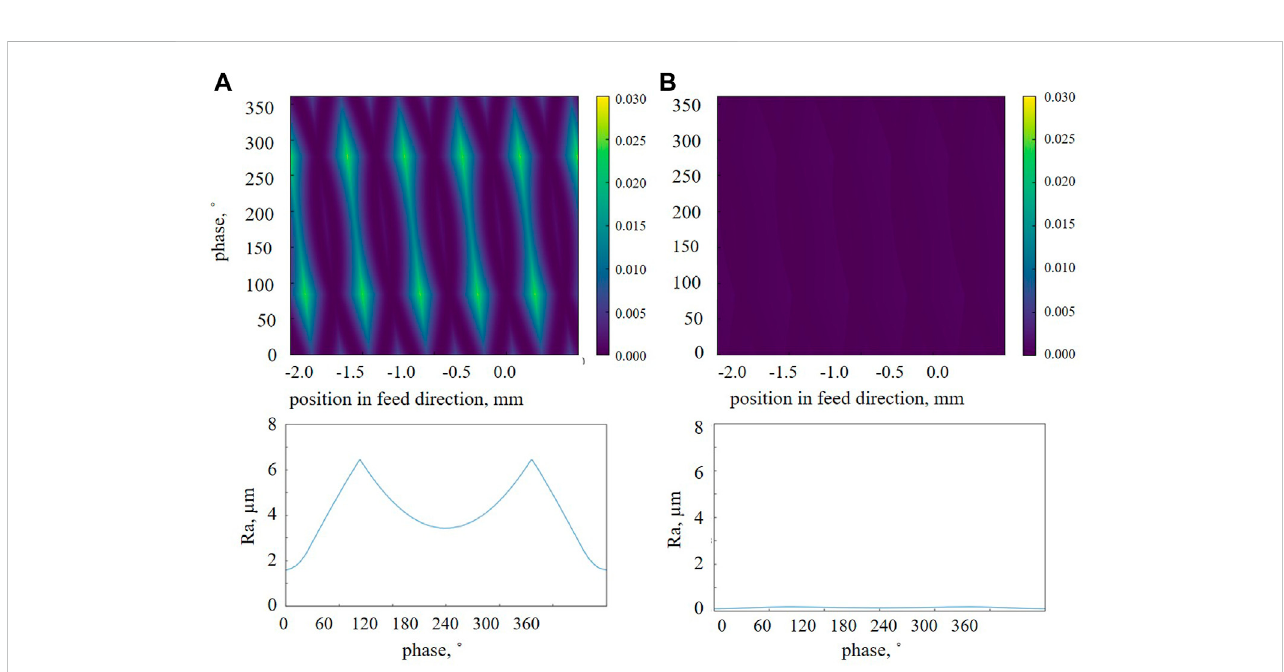
FIGURE 10 Surface roughness simulation of low-frequency vibration cutting ( I = .5 and K =